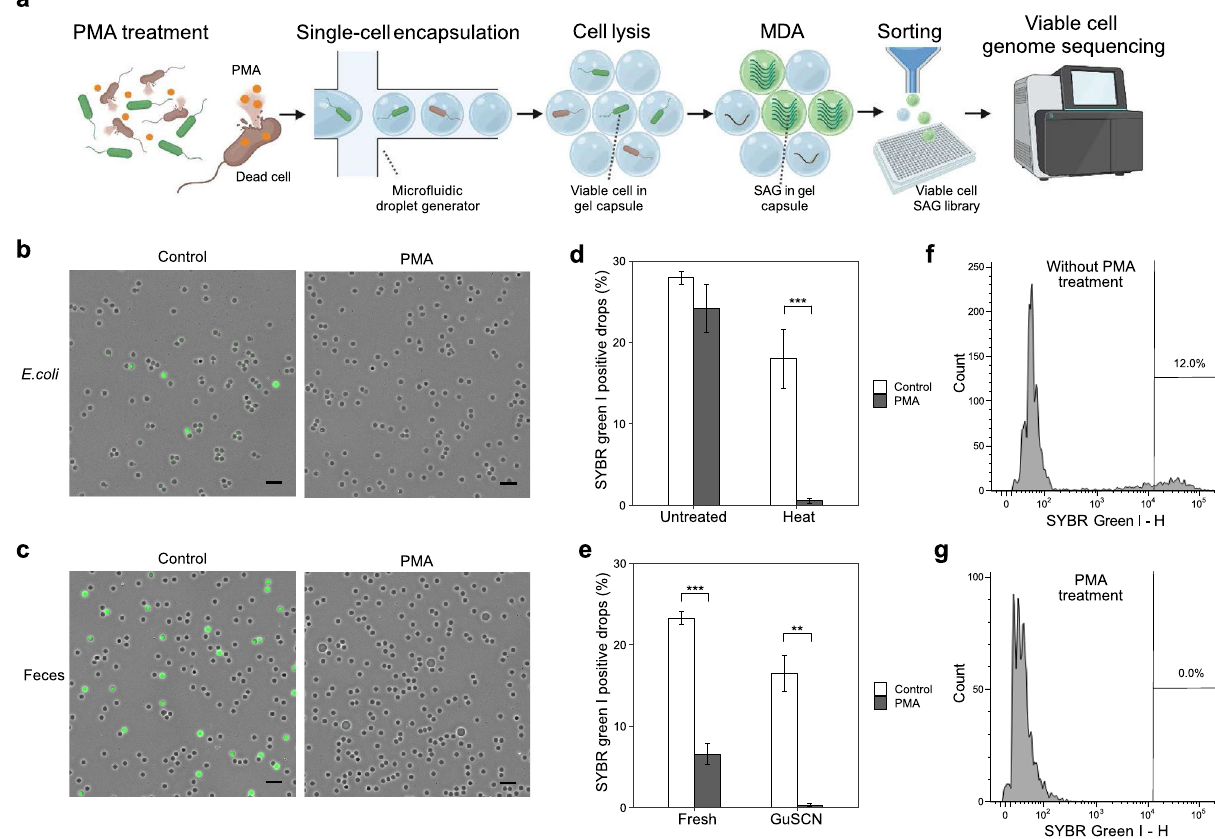
Figure 1. Viable bacteria-targeted single-cell genome amplification with PMA-SAG-gel. ( a ) Workflow of PMA- SAG-gel for single-cell genome sequencing of viable bacterial cells. The bacterial suspension was treated with PMA to prevent DNA amplification from the dead cells. The cells were then randomly captured in gel capsules via a microfluidic droplet generator and processed via in-gel cell lysis and multiple displacement amplification (MDA) in a test tube. Single-amplified genomes (SAGs) obtained from viable cells were fluorescently detected in the gel and sorted into well plates as SAG library for DNA sequencing. ( b , c ) Fluorescent images of gel capsules stained with SYBR green I after MDA from heat-killed E. coli ( b ) and feces suspended in guanidine thiocyanate (GuSCN) solution ( c ). Green signals indicate amplified genomes in gel capsules. Control indicates no PMA treatment. Scale bar; 100 μm. ( d , e ) Number of gel capsules stained with SYBR green I after MDA from untreated or heat-killed E. coli ( d ) and fresh feces or feces suspended in GuSCN solution ( e ). Data are presented as the mean ± SD (n = 3). **p < 0.01; ***p < 0.005 (Student’s t-test ). ( f , g ) Fluorescent intensity histogram of gel capsules analyzed on a flow cytometer using feces suspended in GuSCN without ( f ) or with ( g ) PMA treatment. The gates show the gel capsules to be sorted for subsequent sequencing